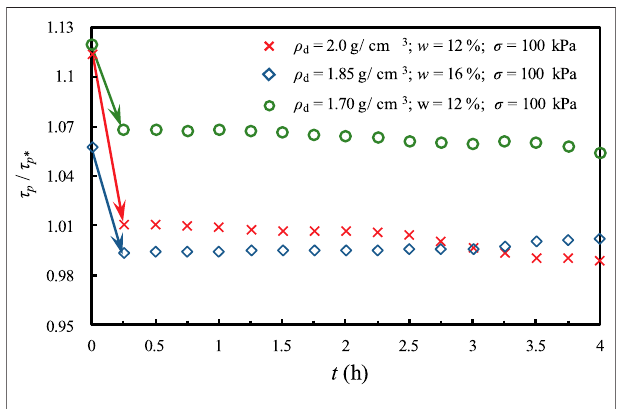
FIGURE 6 | Shear strength with short-term thawing time.